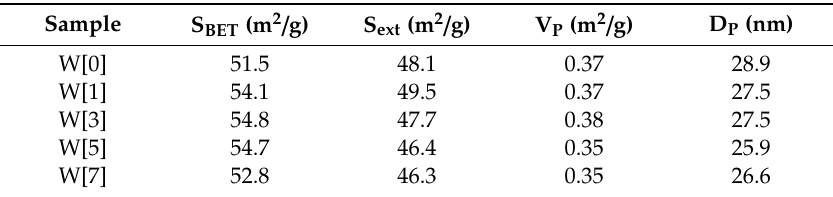
Table 2. Analysis of the structural characteristics of Pt–W[x] / TiO 2 catalysts (BET surface area (S BET